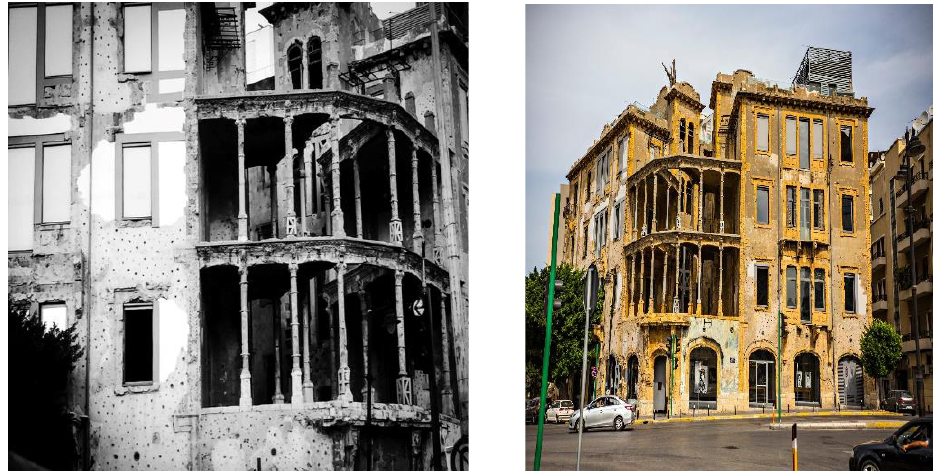
Figure 2. The extent of the destruction suffered in downtown Beirut during the civil war (credit: https://www.shutterstock.com/ (accessed on 15 August 2022)) [13].